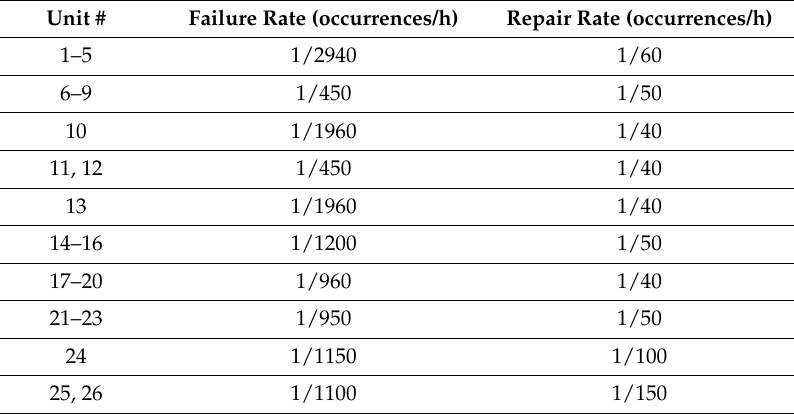
Table A1. Failure and repair rates of 26 generating